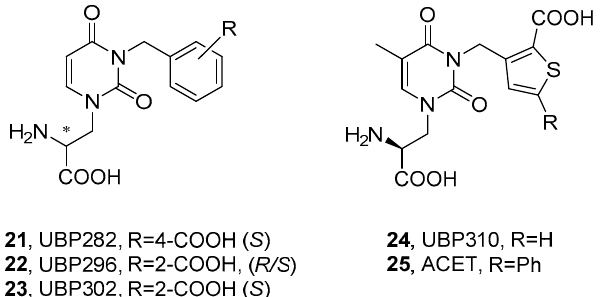
Figure 4. Structures of selected willardiine-based KAR antagonists. * the stereoisomeric center in the